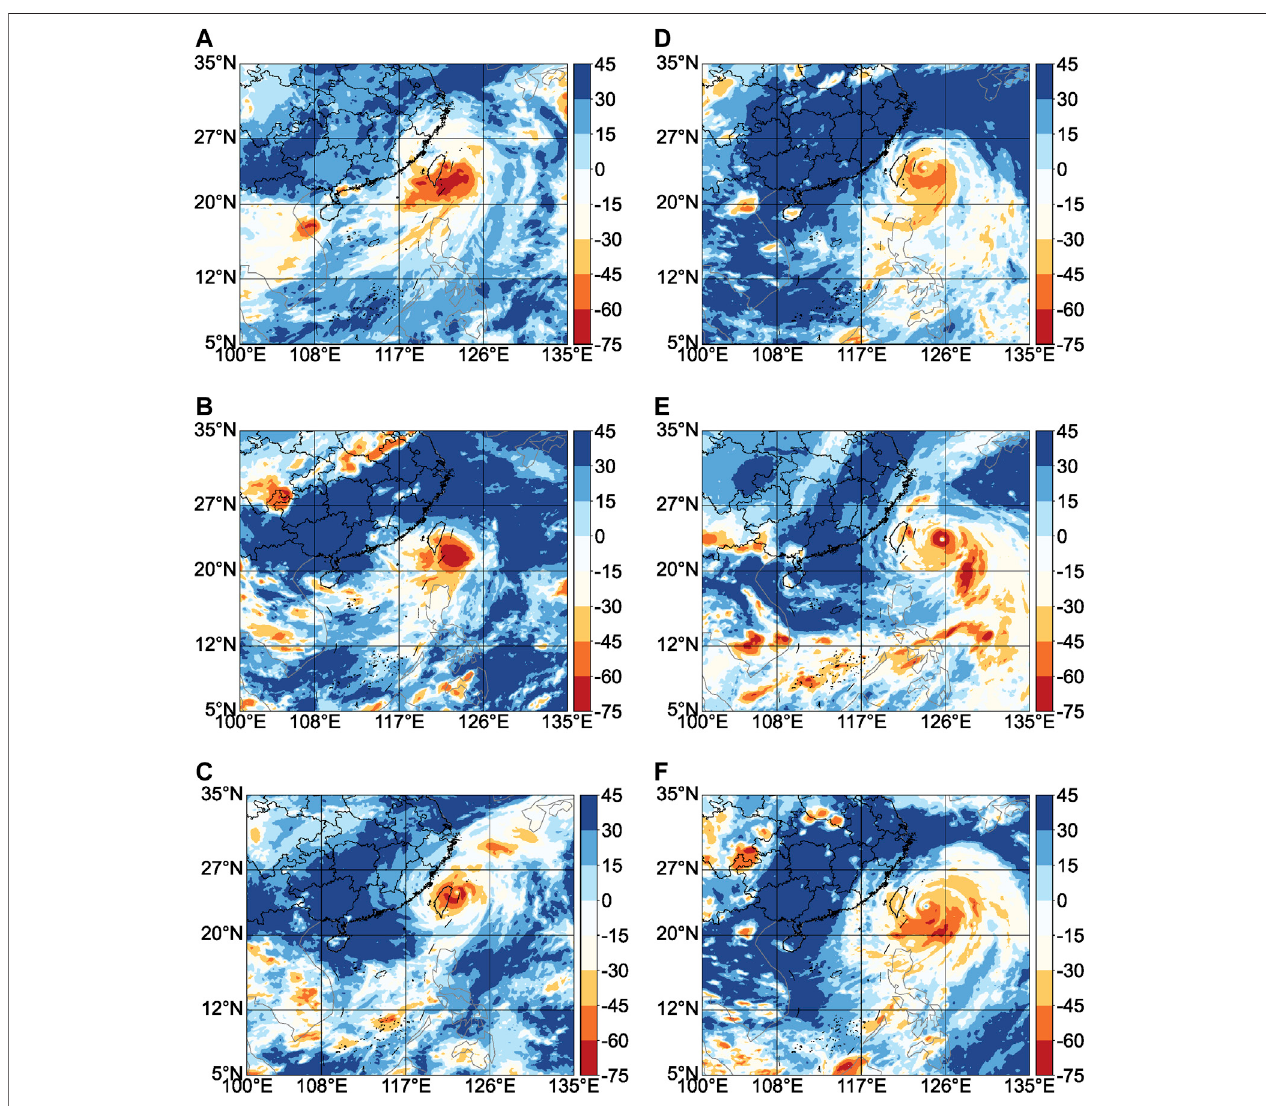
FIGURE 2 | The cloud top brightness temperature (Unit: ° C) from the Chinese geostationary meteorological satellite FY-2 for the ERLTC cases [ (A – C) indicate Morakot, Soulik and Hagupit, respectively] and NERLTC cases [ (D – F) indicate Kong-Rey, Wipha and Haitang respectively] 1 day before the extreme or non-extreme rainfall. Data for Herb, Gloria, Fred and Kaemi are unavailable, the corresponding fi gures omitted here.